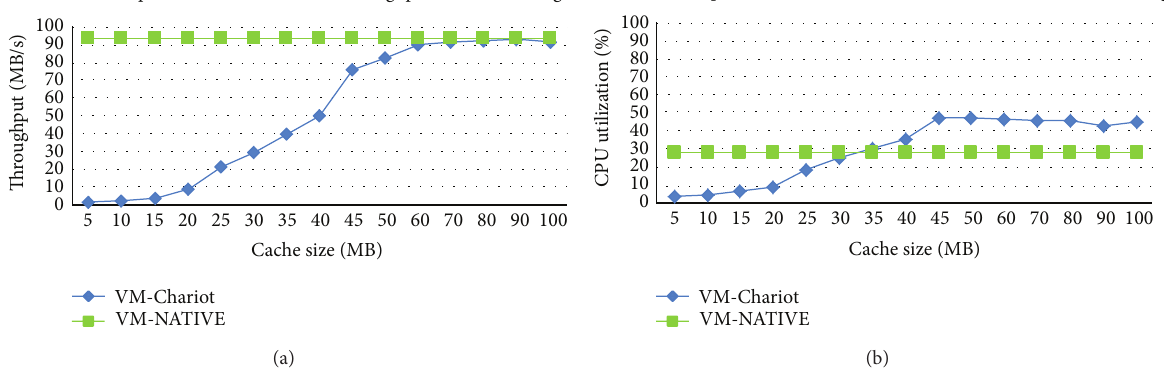
Figure 5: The sending performance of TCP benchmark impacted by different cache